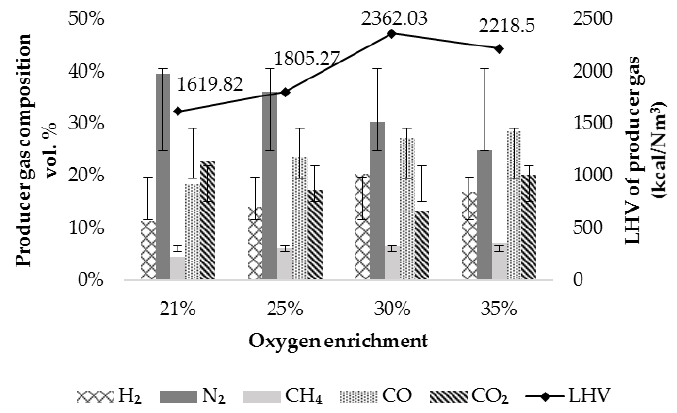
Figure 5. Composition and LHV of the producer gas.